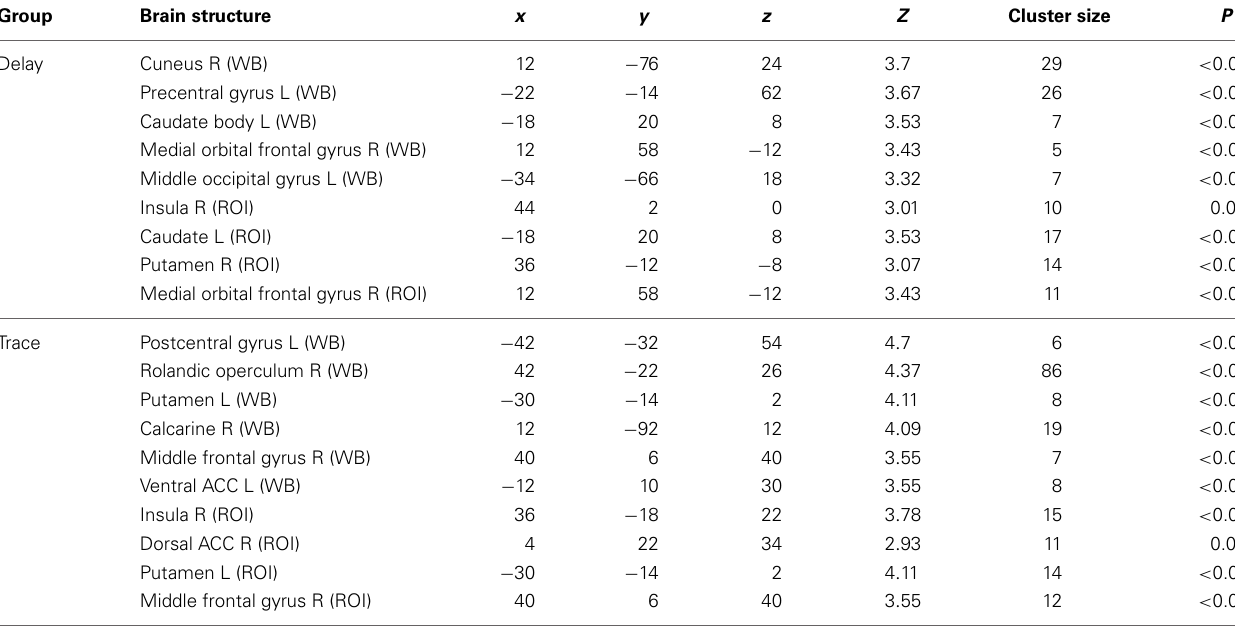
Table 1 | Significant activations revealed by whole brain (WB) and regions of interest (ROI) analysis for contrast CS + > CS − during early extinction.